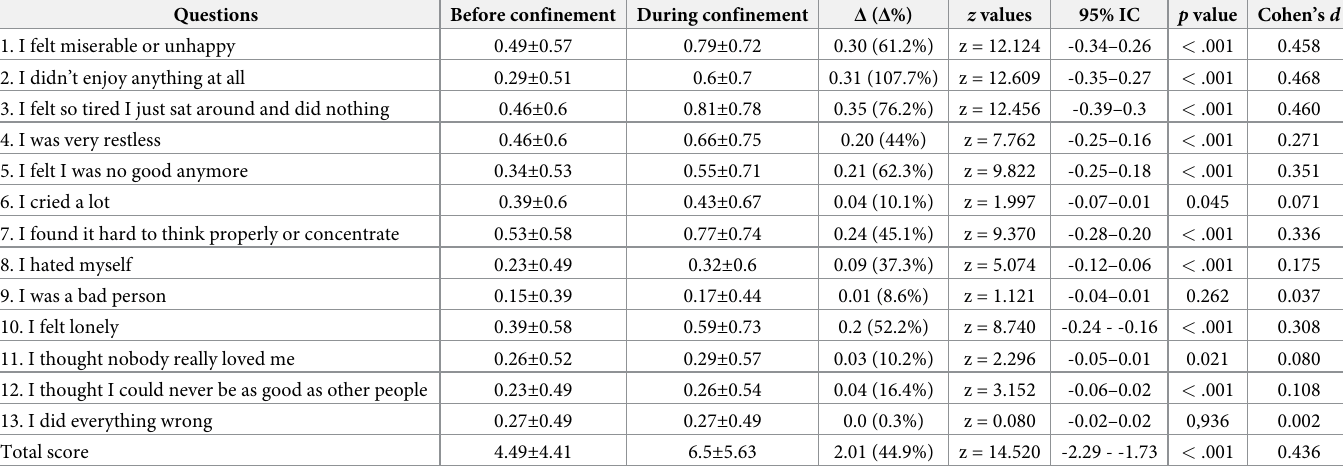
Table 3. Responses to the Short Mood and Feelings Questionnaire before and during home confinement.